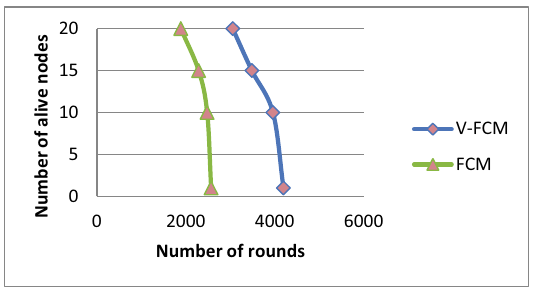
Fig: 9 Number of alive nodes VS Number of rounds The proposed algorithm is made to run for determining the simulation time taken by the number of rounds VS first node dead for FCM and Voronoi fuzzy clustering algorithm. The